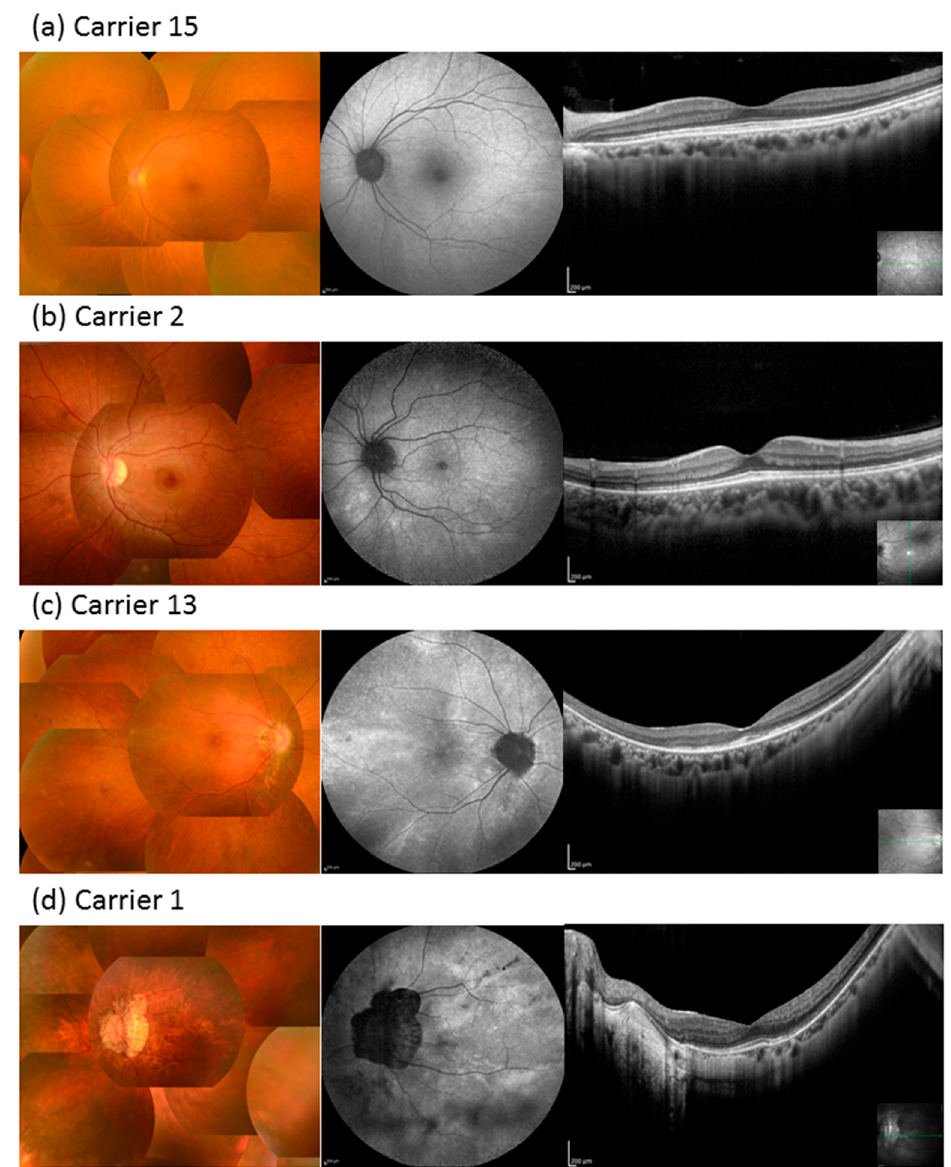
Figure 4. Color fundus photography, fundus autofluorescence (FAF), and optic coherence tomography (OCT) of carrier female subjects in this study. ( a ) Fundus findings of Carrier 15. Color fundus photography revealed no abnormalities (grade 0). FAF revealed a somewhat radial pattern. No obvious abnormalities were detected on OCT. ( b ) Fundus findings of Carrier 2. Tapetal reflex was detected temporal to the macula (grade 1). FAF revealed a radial pattern and there were no obvious abnormalities on OCT. ( c ) Fundus findings of Carrier 13. Pigmentary change was detected in the temporal peripheral retina (grade 2). FAF showed a radial autofluorescent pattern. The ellipsoid zone was extinguished in the temporal retina on OCT. ( d ) Fundus findings of Carrier 1. Diffuse retinal atrophy including pigmentary disturbance was observed (grade 3). FAF showed a radial autofluorescent pattern and hypoautofluorescence consistent with retinal pigment epithelium atrophy. OCT showed severe atrophy of the outer retina and choroid. Scar bar = 200 µ